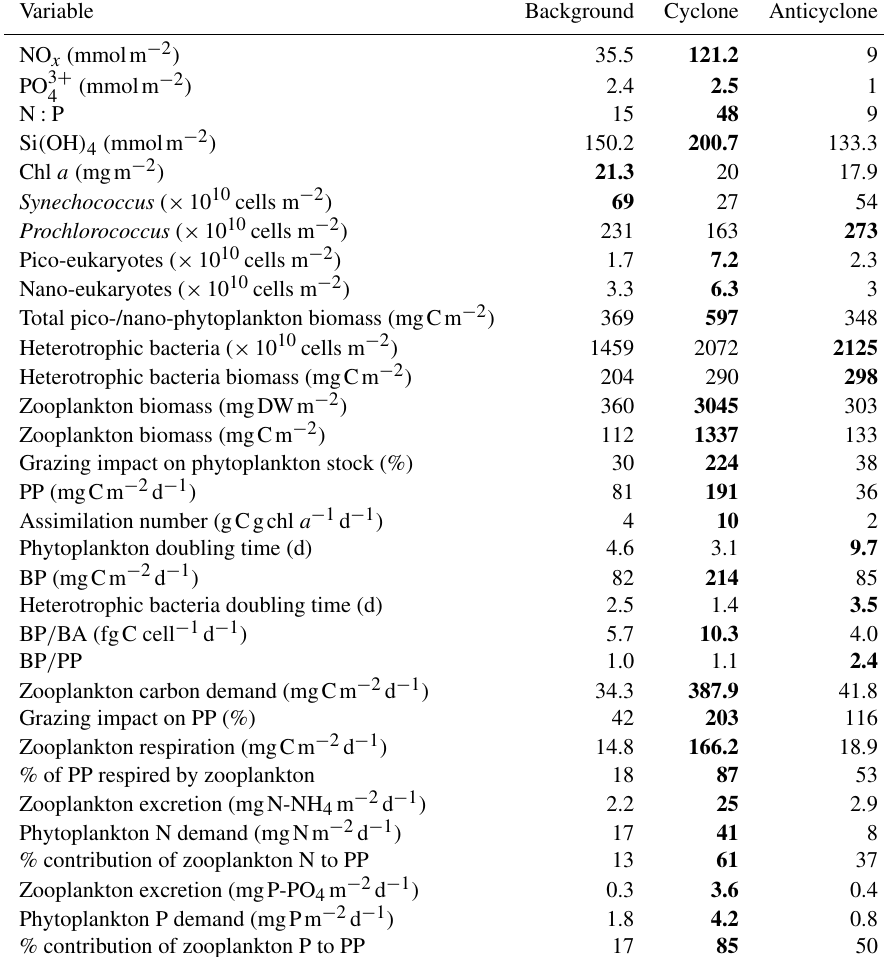
Table 1. Chemical and biological integrated values at the upper 180m (except zooplankton where 0–300m is presented) measured at the different sampling sites. The maximal values for each variable are highlighted in